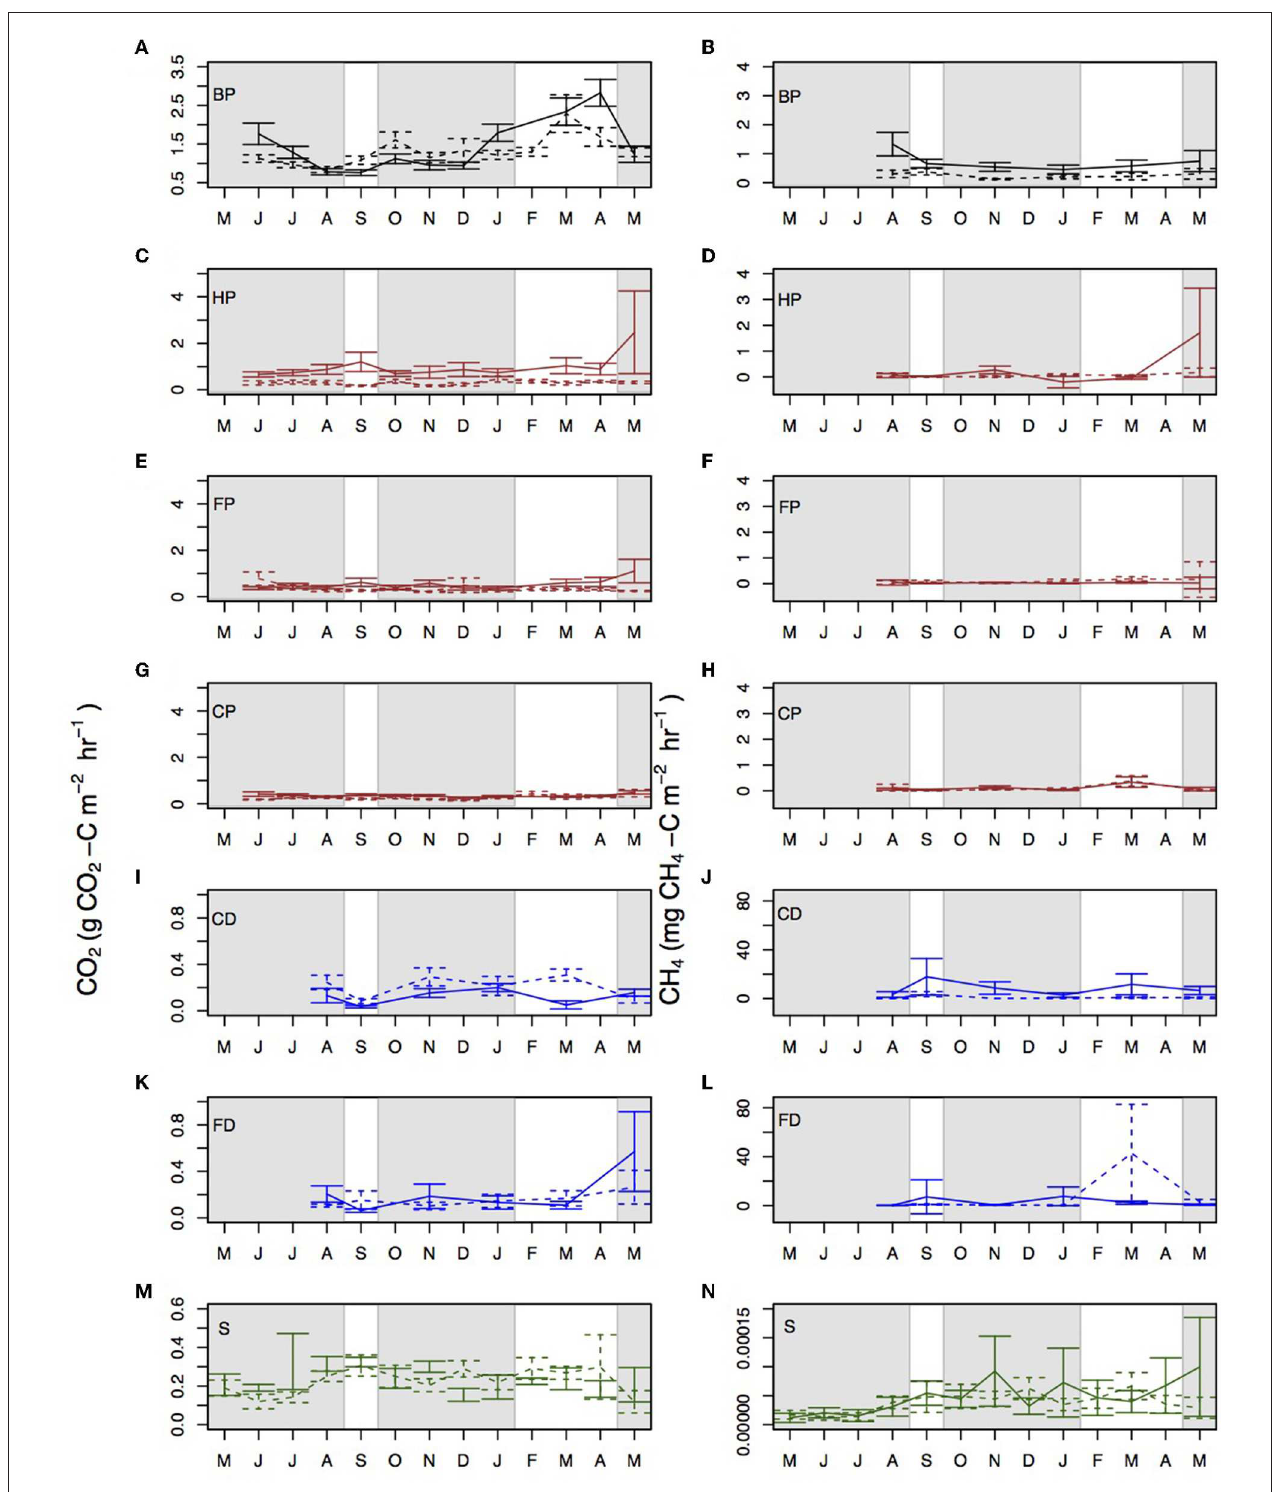
FIGURE 4 | Monthly mean CO 2 and CH 4 measurements taken from the different surface microforms in Sabaju (continuous line) and Sebungan (dashed line) for (A) by palm CO 2 , (B) by palm CH 4 , (C) harvest path CO 2 , (D) harvest path CH 4 , (E) frond pile CO 2 , (F) frond pile CH 4 , (G) cover plants CO 2 , (H) cover plants CH 4 , (I) collection drain CO 2 , (J) collection drain CH 4 , (K) field drain CO 2 , (L) field drain CH 4 , (M) stem CO 2 , and (N) stem CH 4 . Microform acronyms are in the top left of